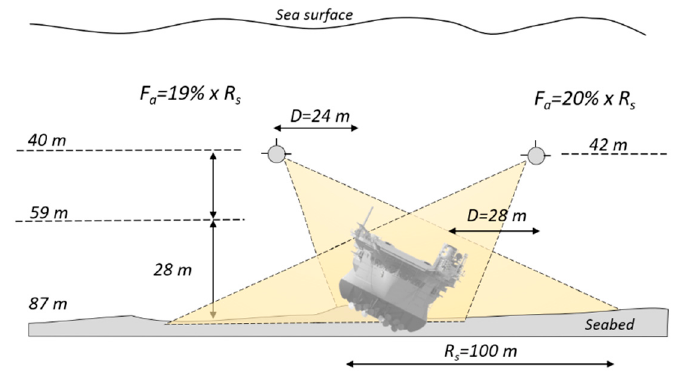
Figure 25. Diagram of the proposed operating parameters used in the sonar study of the GZ wreck giving optimal angles of illumination with the acoustic beam.